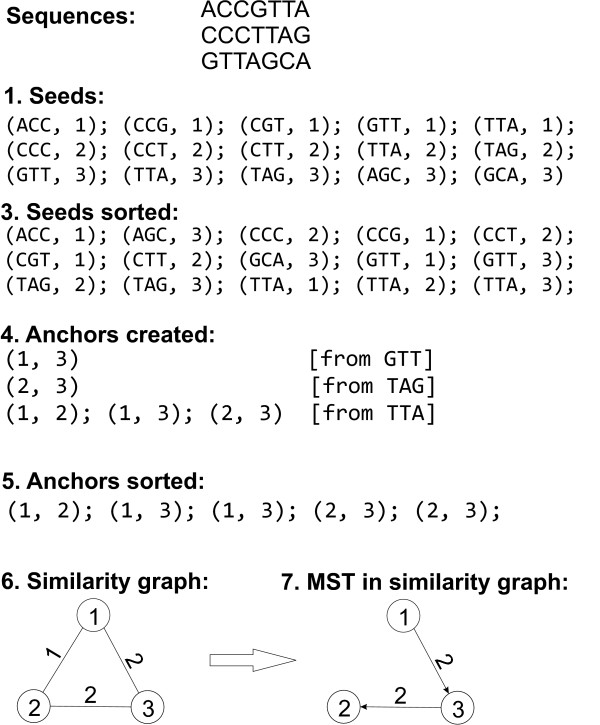
Top level illustration of the algorithm of Section 2.3 for construction of the similarity graph for three sequences. To simplify the illustration we do not consider here the reverse complement reads and the filtering of Step 2. The encoding that corresponds to the tree can be found in Section 2.4.